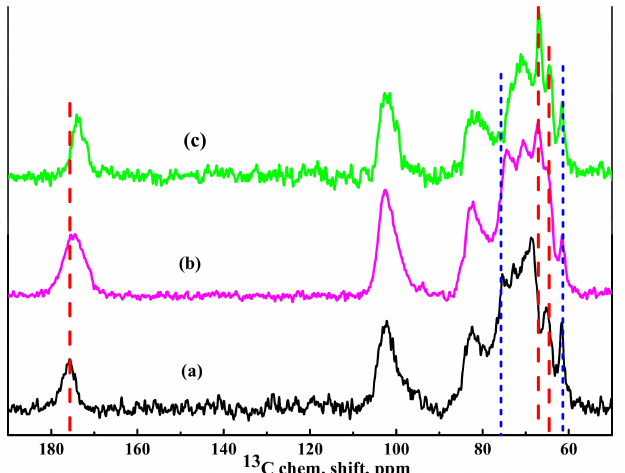
Figure 7. 13 C NMR spectra of the cross-linked ( a ) HEC/SA CaCl2 , ( b ) HEC/SA CA , and ( c ) HEC/ SA PA